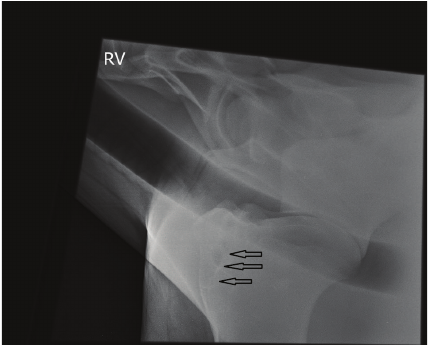
Figure 8: Lateromedial projection of the humerus 15 months after surgery: the bone defect of the humeral greater tubercle shows radiopaque content within a sclerotic